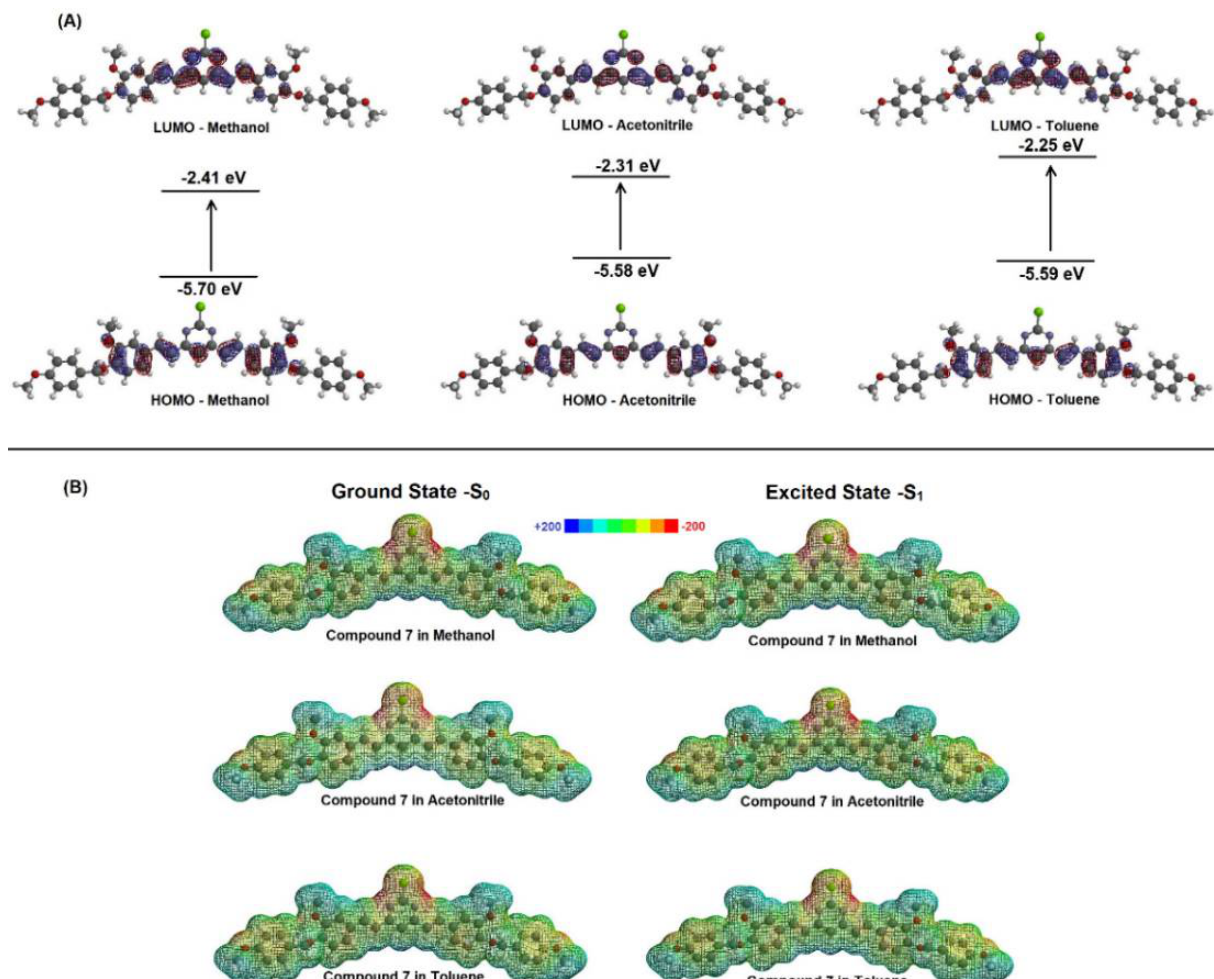
Figure 4. ( A ) HOMO-LUMO density for the compound 7 in methanol, acetonitrile and toluene. ( B ) Molecular electrostatic potential (MEP) map for the compound 7 (in a.u.) in three different solvents.